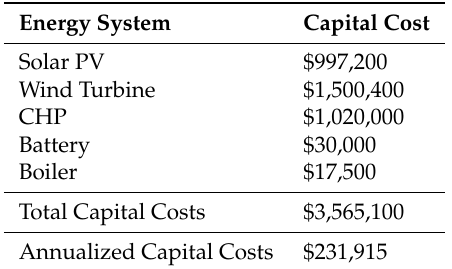
Table A7. Capital costs of the proposed DES